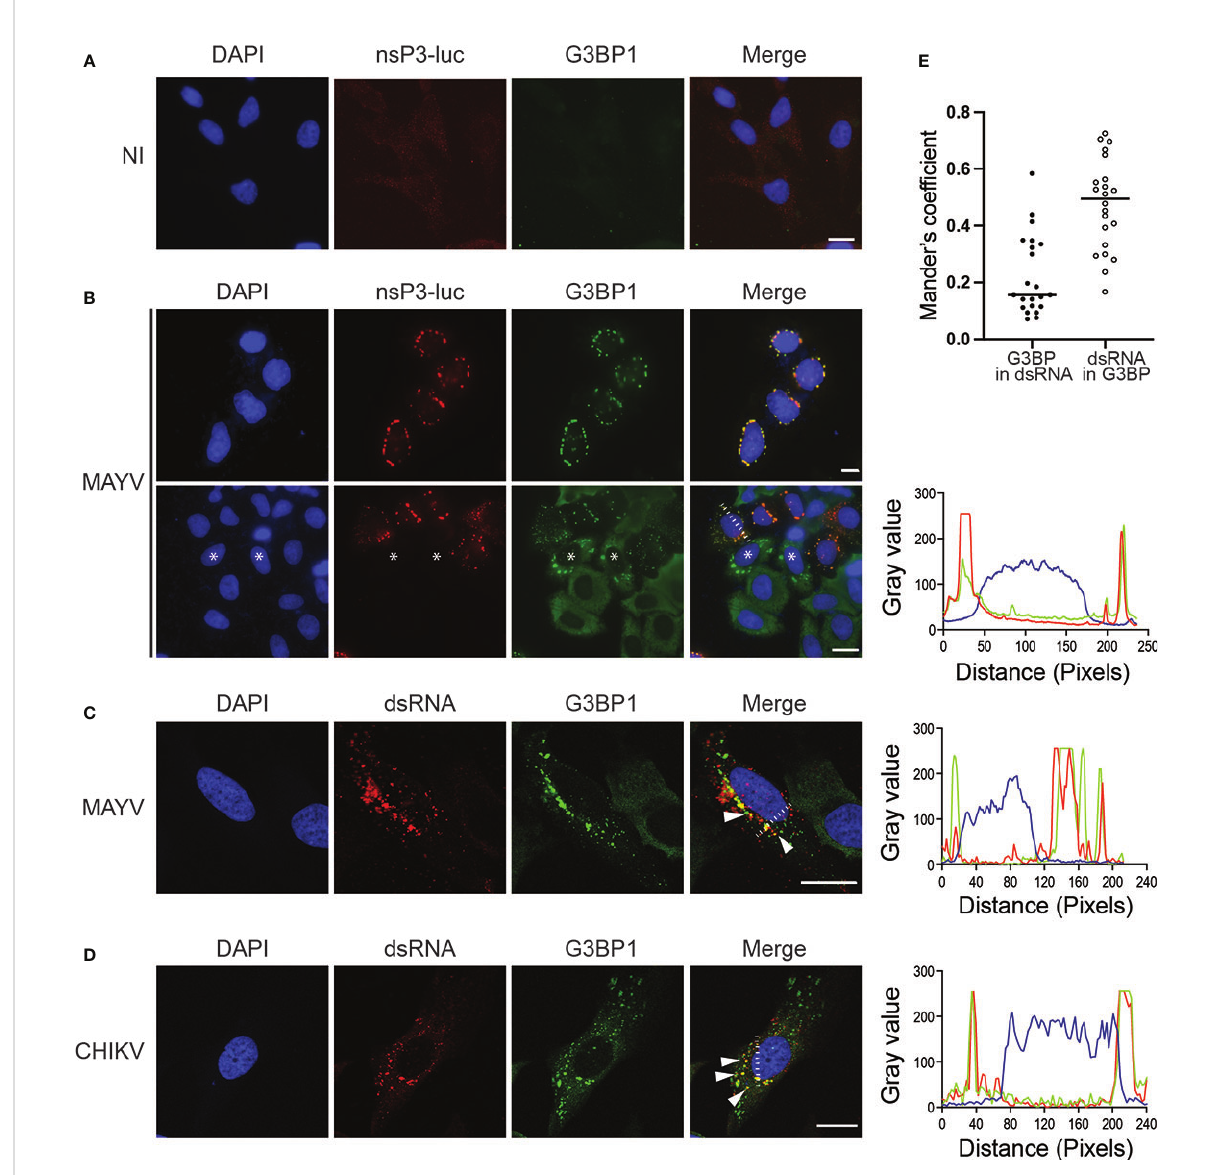
FIGURE 3 MAYV nsP3 and G3BP1 are colocalized to cytosolic granules in the cytoplasm of infected cells. HeLa cells were either left uninfected (NI) (A) or infected with MAYV-luc at a MOI of 0.5 for 24 h (B) and stained with antibodies for luciferase or G3BP1. Nuclei were strained with DAPI. Representative images are shown. * Indicates some uninfected cells. Cells infected with MAYV-luc (C) or CHIKV-nanoLuc (D) using the same experimental procedure were labeled for dsRNA, G3BP1, and nuclei were stained with DAPI. Foci of colocalized fl uorescence are indicated by arrows. Scale bars = 20 µm. Fluorescence intensity pro fi le corresponding to the white line is shown on the right. (E) Mander ’ s overlap coef fi cient was calculated between G3BP and dsRNA from experiment shown in (C) (n = 22